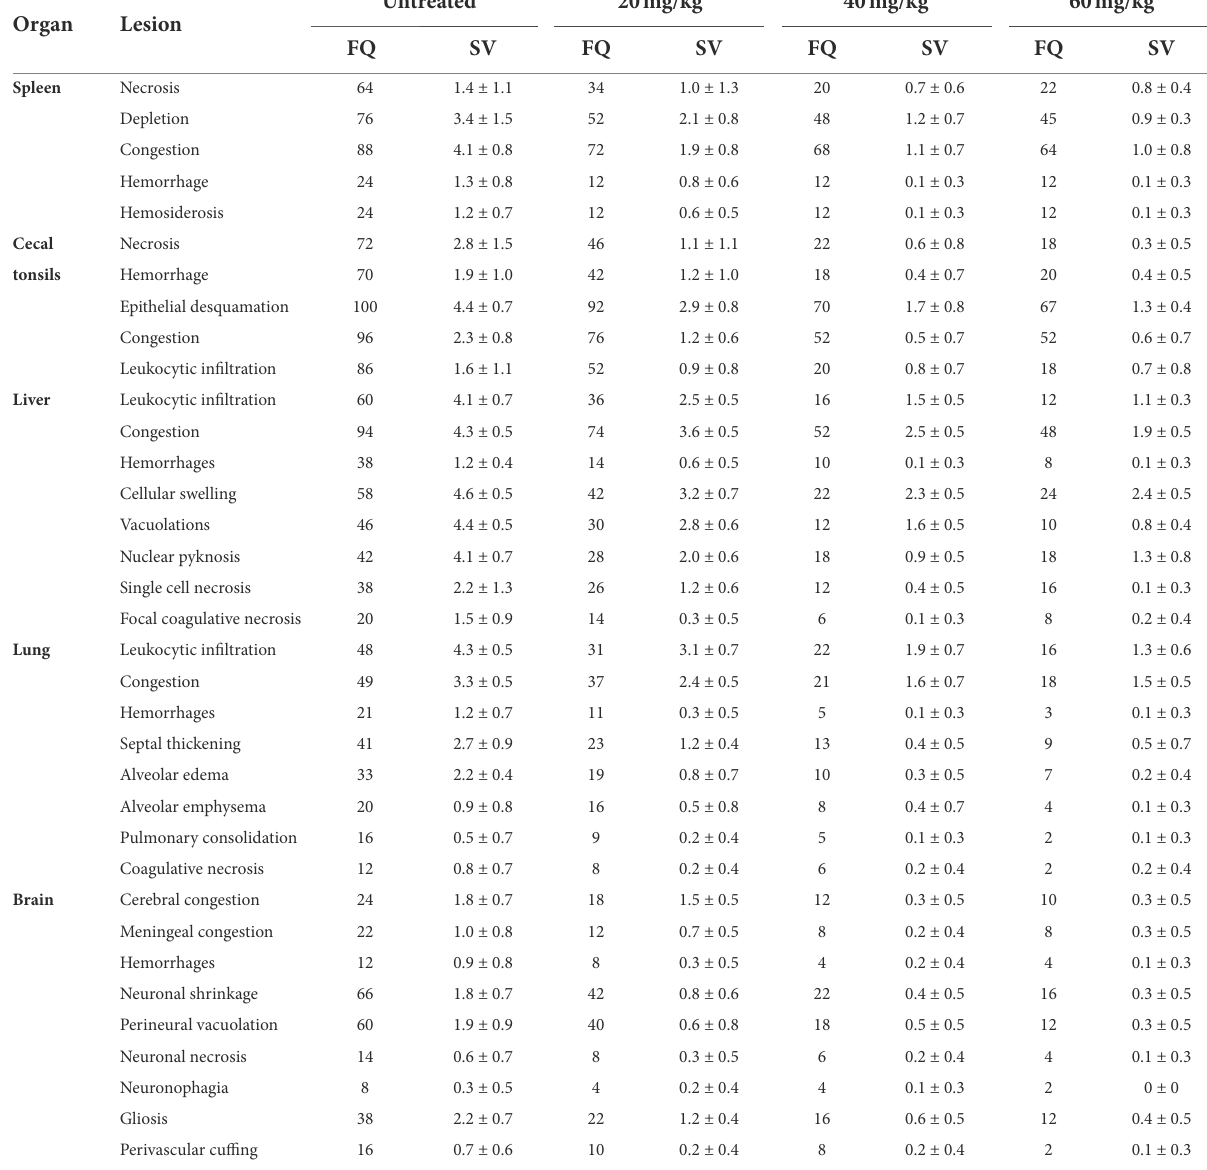
TABLE 2 Effect of 20, 40, and 60 mg/k.g BW n -docosanol on the frequency and severity of NDV-induced histopathological lesions in different body tissues of experimentally infected